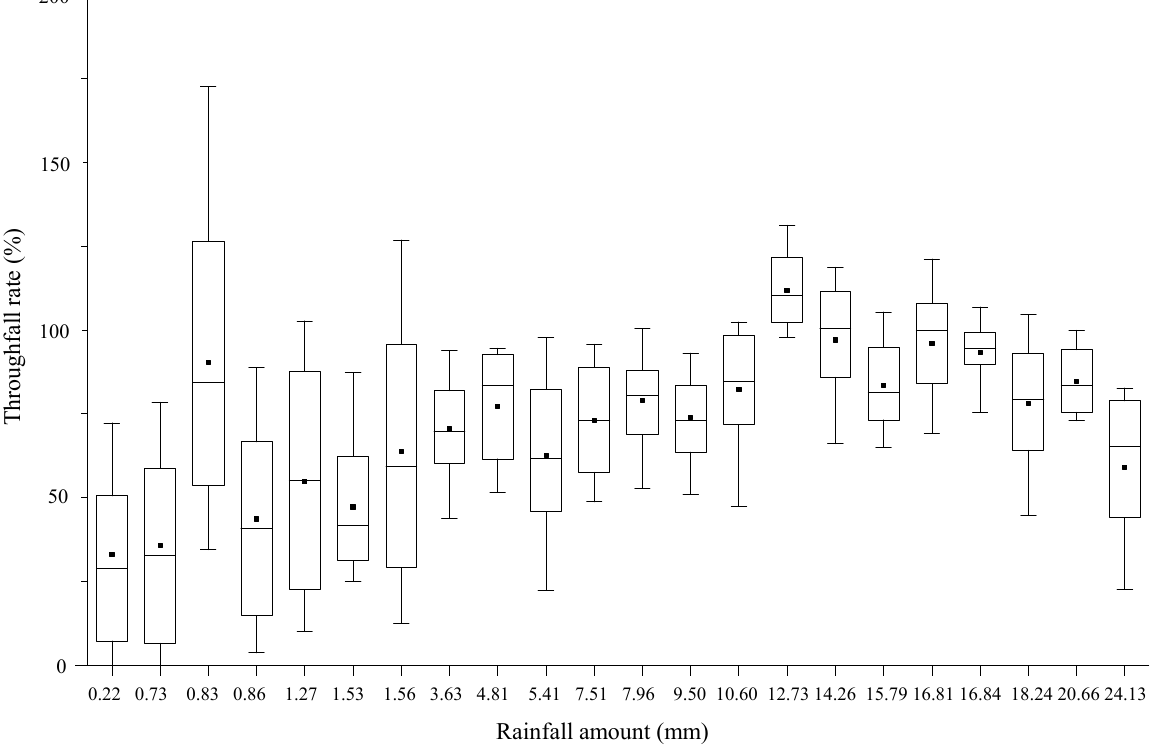
Figure 4. Box and whisker plots of throughfall rate against rainfall amount. The center line, black solid squares, bottom and top of the boxes represent the median, average, 25th and 75th percentiles, respectively. The whiskers represent the 5th and 95th percentiles.